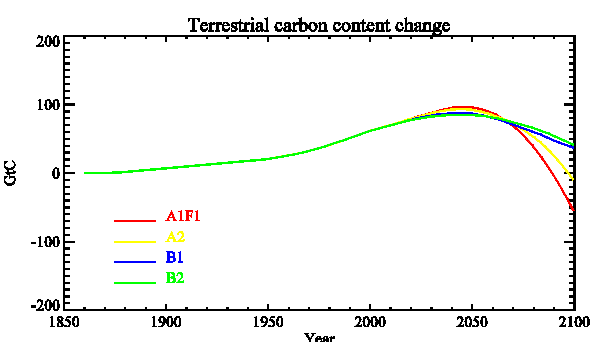
Figure 4: IMOGEN EBM2 calculation of change in total terrestrial carbon from 3 Fig. 4. IMOGEN EBM2 calculation of change in total terrestrial 1860 (both vegetation and soil, and across all land points except Antarctica) and for 4 carbon from 1860 (both vegetation and soil, and across all land four SRES scenarios (but for the CO 2 -only component, i.e. no non-CO 2 GHGs). 5 points except Antarctica) and for four SRES scenarios (but for the CO 2 -only component, i.e. no non-CO 2